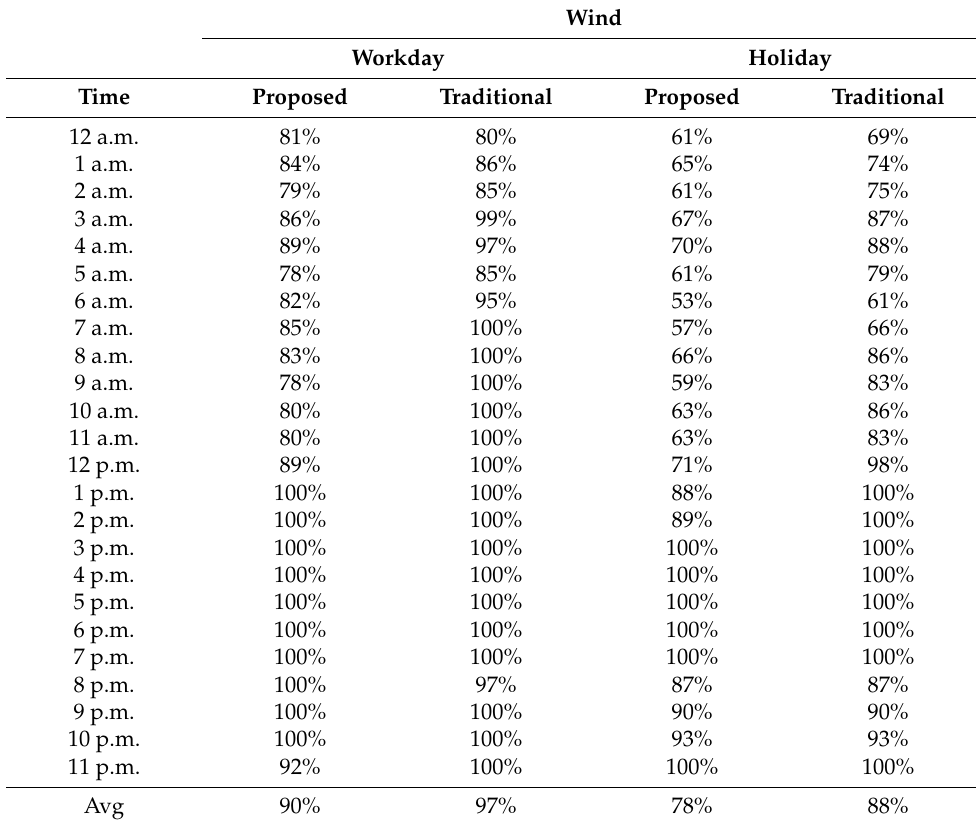
Table 6. The optimal VRE output level during a day of case 6: the scenario of VRE without support (% of the generators’ maximum